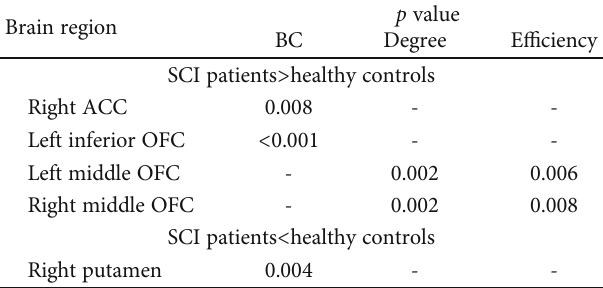
Table 4: Brain regions are showing signi fi cant di ff erences in any of the three nodal characteristics.